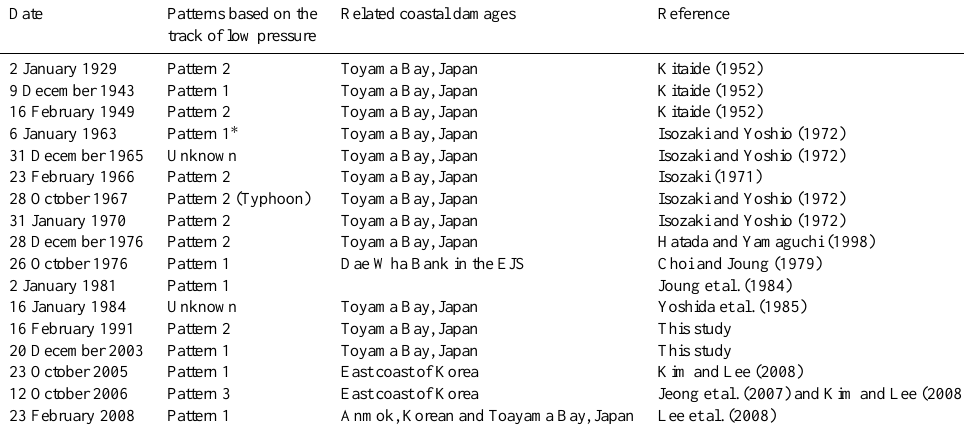
Fig. 14. Distribution of calculated maximum significant wave heights for domains 1, 2, 3, and 4 for the event of February 2008.